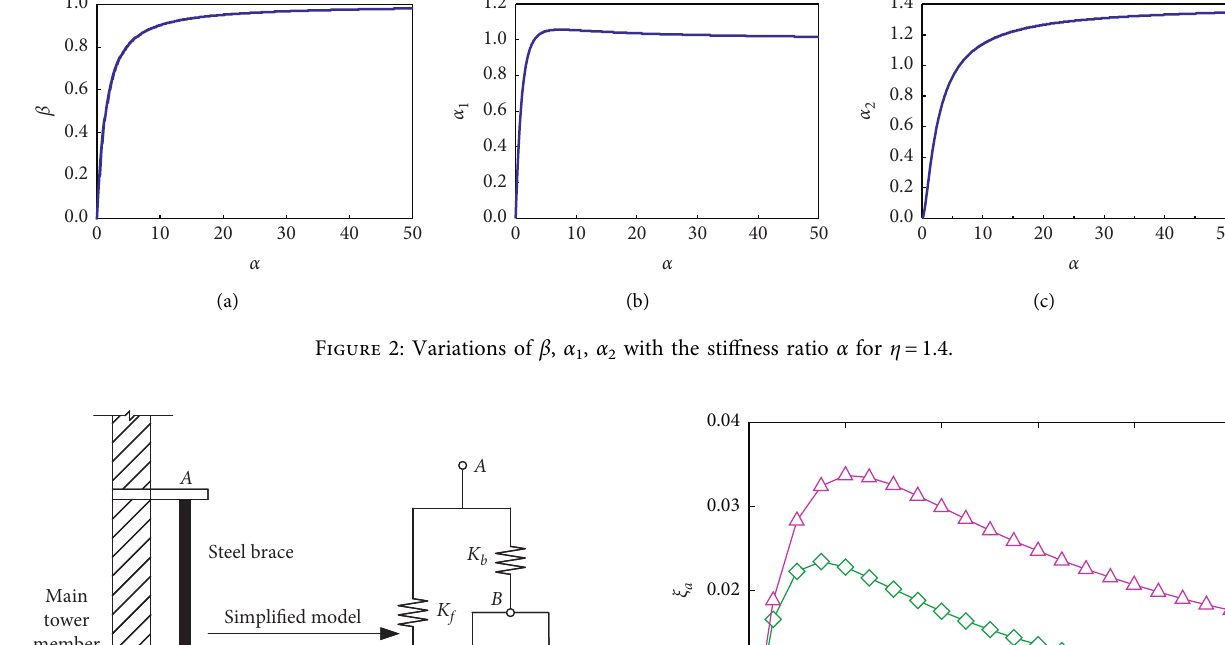
Figure 5: Variations of the equivalent damping ratio ξ spect to α d under various α b